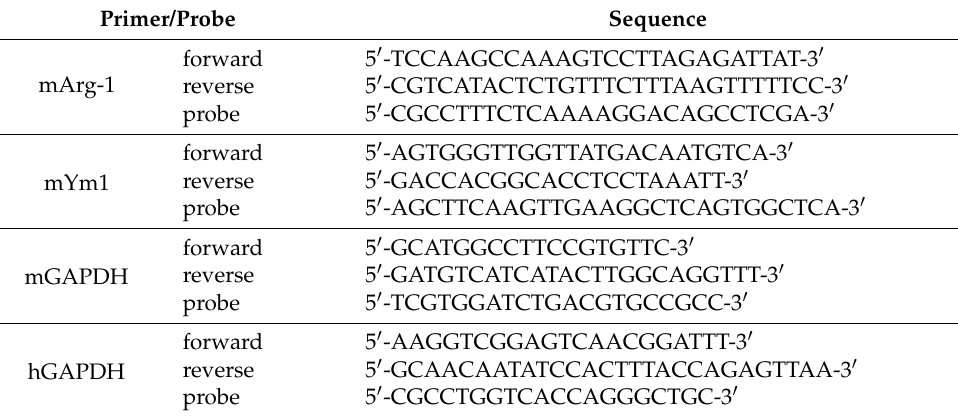
Table 1. In-house designed primer and probe sequences used in